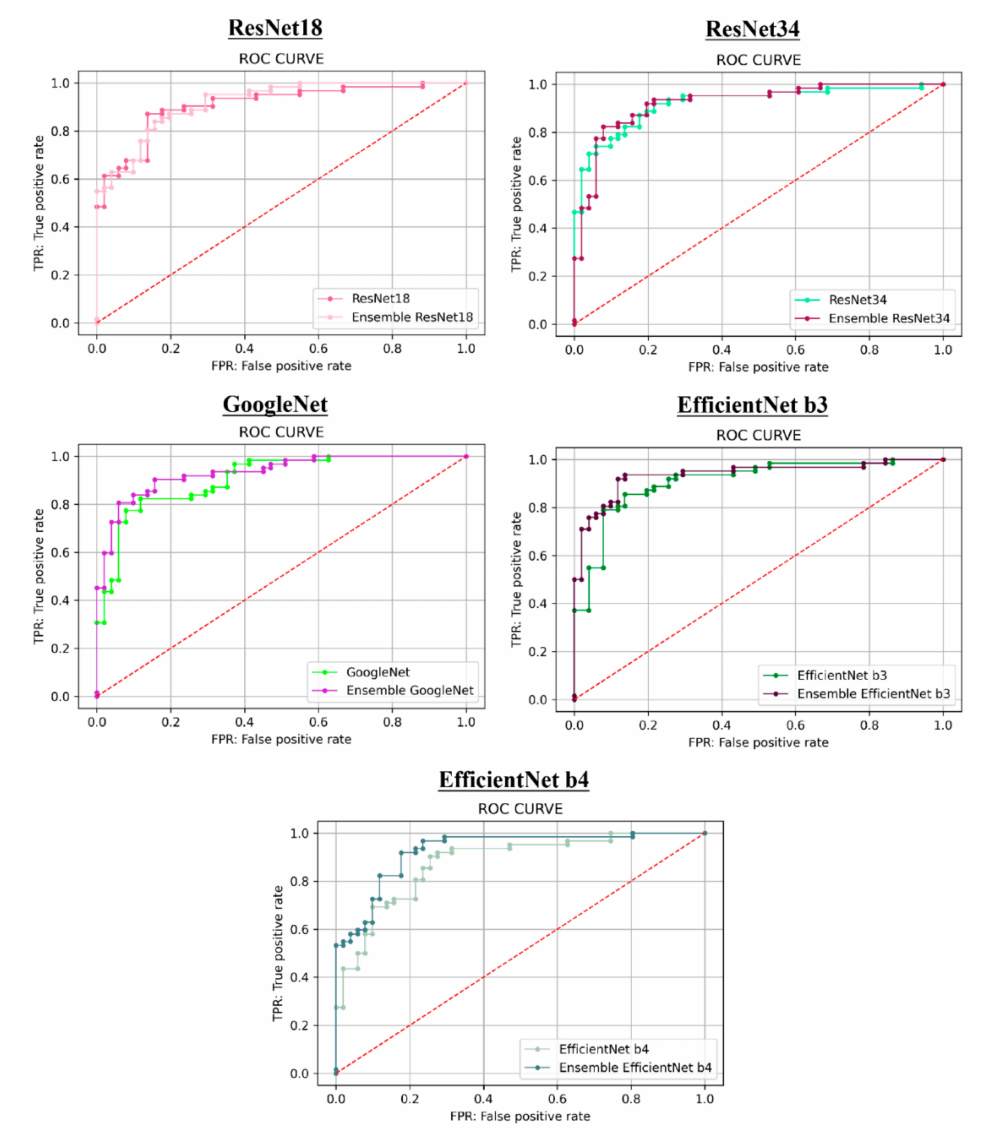
Figure 3. ROC curves for each of the CNN models with hip radiographs alone and the CNN analysis with hip radiographs combined with clinical covariates